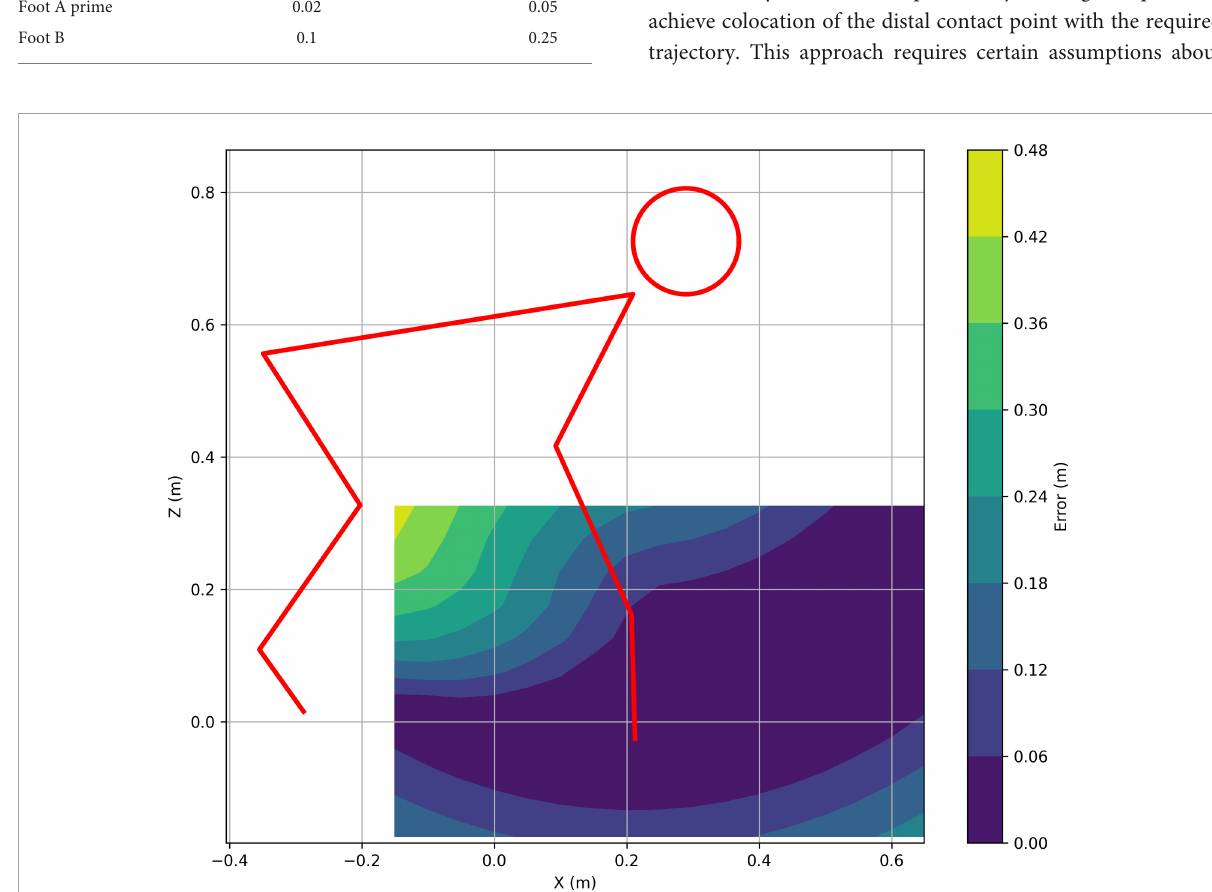
FIGURE2 Contour plot of the colocation error magnitude for the forelimb tracking a target. The low error zone in dark blue shows the effective domain of the controller with the specified angular excursions, and the red line shows the initial pose of the